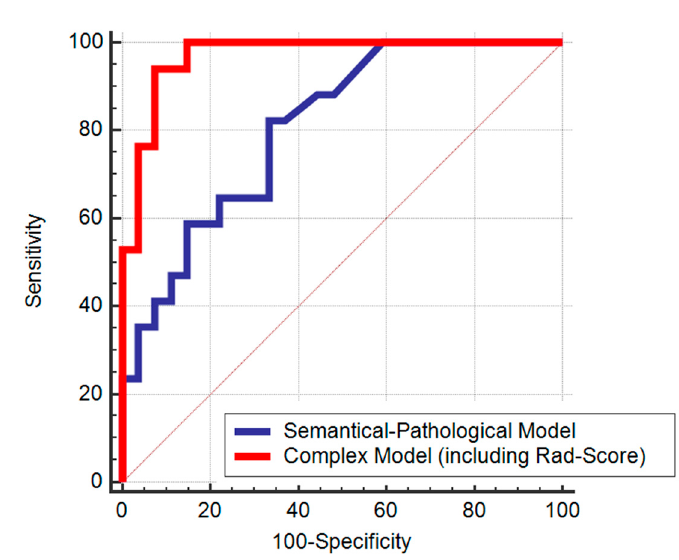
Figure 4. ROC curves of the semantical-pathological and complex models score for predicting LARC non-responders.